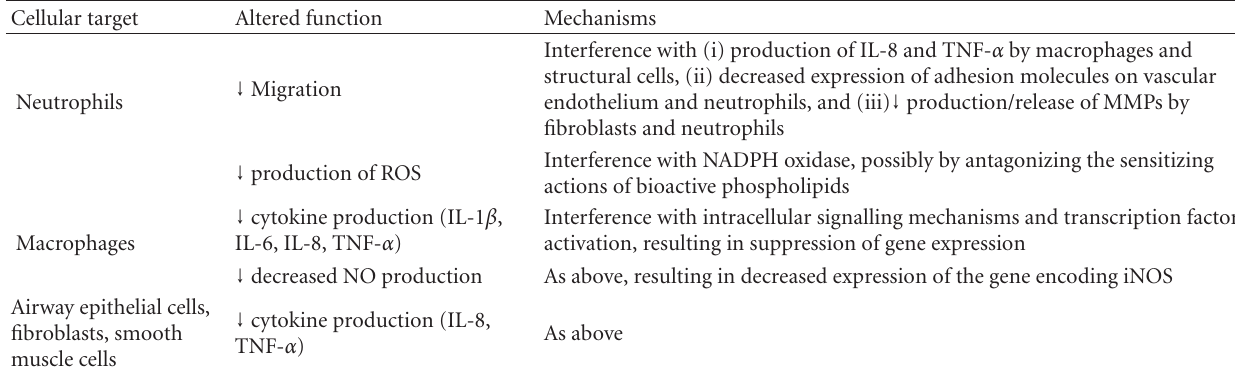
Table 2: Anti-inflammatory e ff ects of macrolides on phagocytes and structural cells.